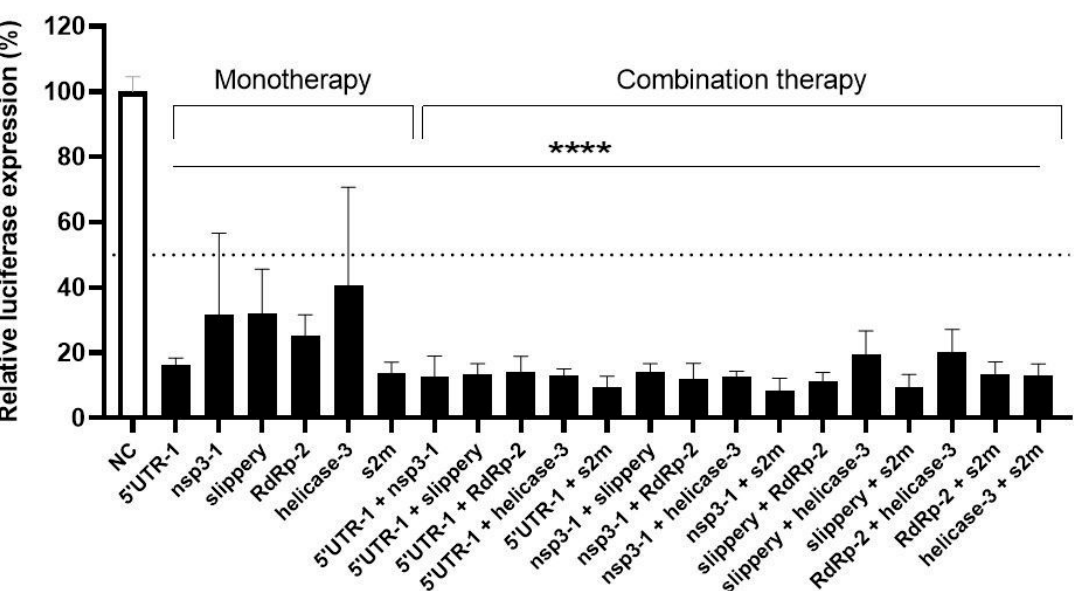
Figure 5. The anti-SARS-CoV-2 efficiency of single versus dual crRNA therapy. The efficiency of six crRNAs was tested in HEK293T cells by co-transfecting them with the luciferase construct encoding SARS-CoV-2 +RNA target sequences. The crRNAs were tested as single inhibitor versus a dual-combinatorial approach. To quantify viral gene expression, luciferase level was measured at two days after transfection. Mean values (±SD) of three experiments in duplicates are shown. The average luciferase levels are expressed as percentage (%) of luciferase expression, setting the negative control (NC) at 100%. Statistical significance was determined using one-way ANOVA, **** p ≤ 0.0001.